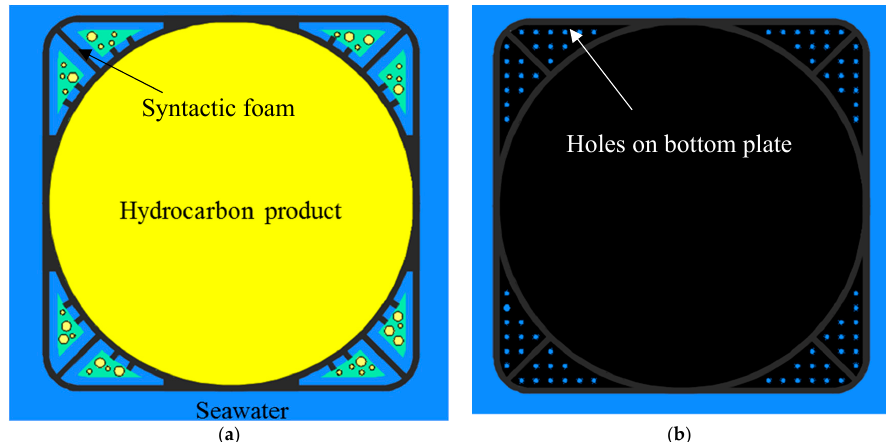
Figure 30. Use of syntactic foam as floaters: ( a ) configuration and ( b ) bottom plate.